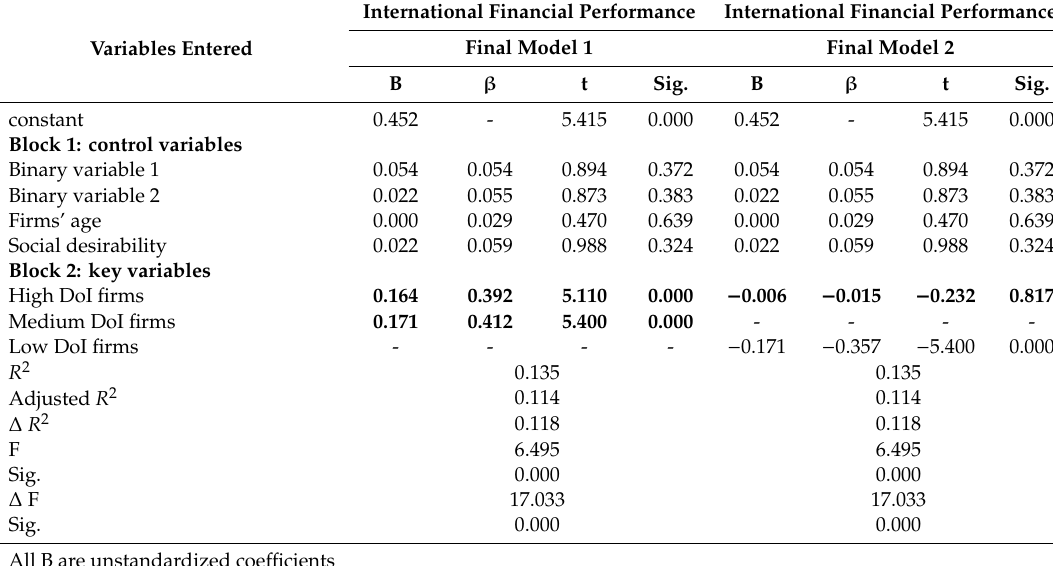
Table 2. Regression analysis (international financial